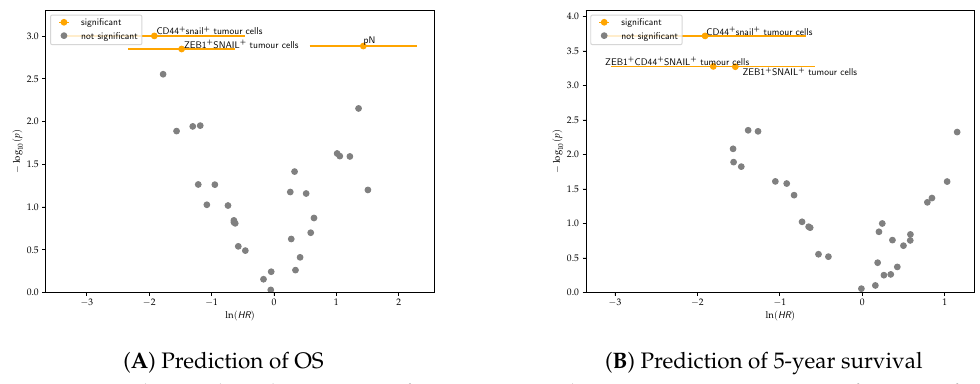
Figure 11. Volcano plots showing significant categorical univariate Cox regression features after Chow–Denning correction and their correlation with ( A ) OS and ( B ) and 5-year survival in the WS cohort. Features with log ( HR ) > 0 are positively correlated with the event, whereas those with log ( HR ) < 0 are negatively